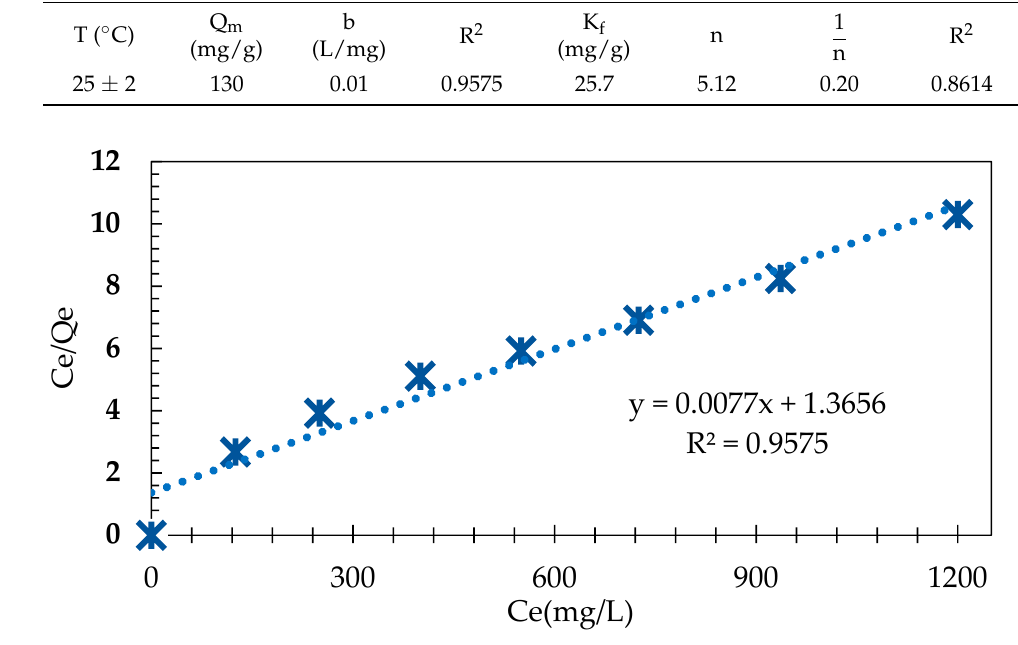
Figure 5. Linear regression of the Langmuir isotherm regarding AB 113 adsorption onto IRA 402(Cl − ) mass. Freundlich